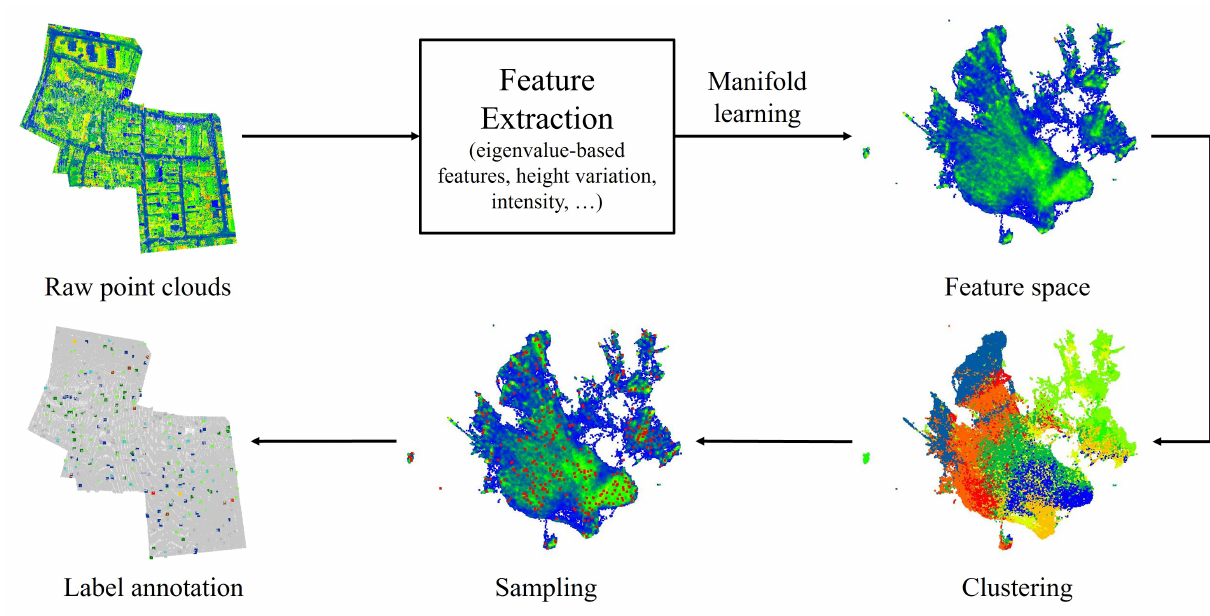
Figure 1. Framework of the feature-constrained weak-label initialization. Handcrafted features were developed to extract point-wise discriminative information. Subsequently, a manifold learning method was proposed to combine extracted features by projecting onto a more informative feature space. To ensure that the entire feature space was cross-sampled, the data were divided into clusters based on which weak labels are acquired using a density-biased selection strategy. Table 1. Feature description of a point